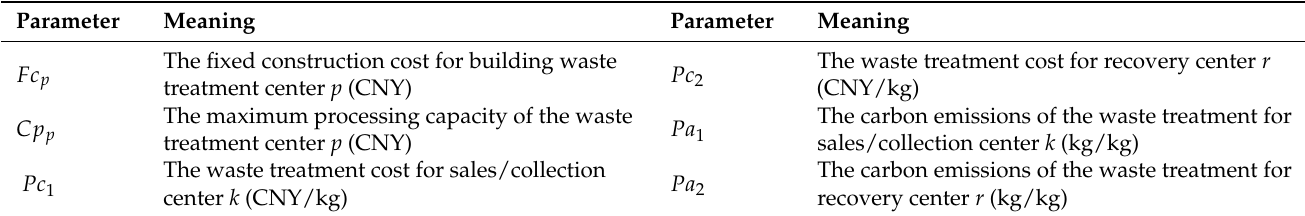
Table 7. Relevant parameters of the waste treatment